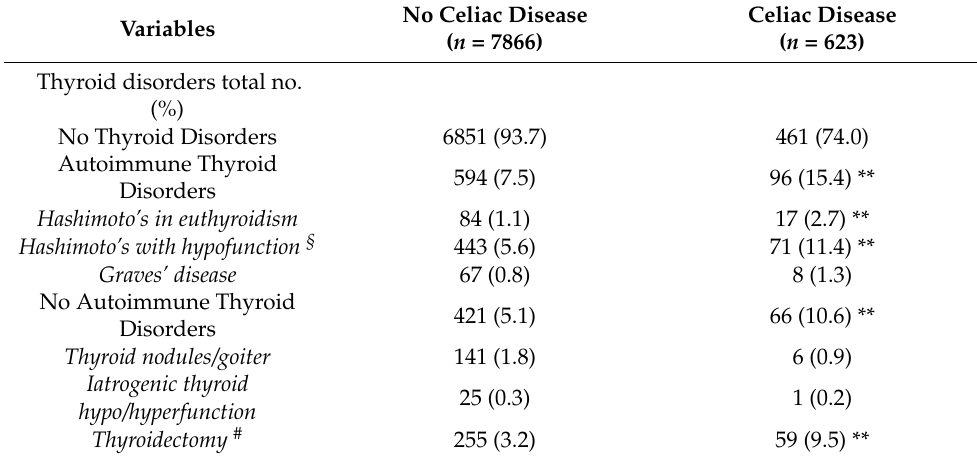
Table 2. Frequency of thyroid disorders in adult patients according to presence of celiac disease.